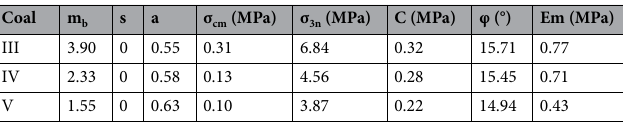
Table 4. Mechanical parameters of class III–V coal mass.